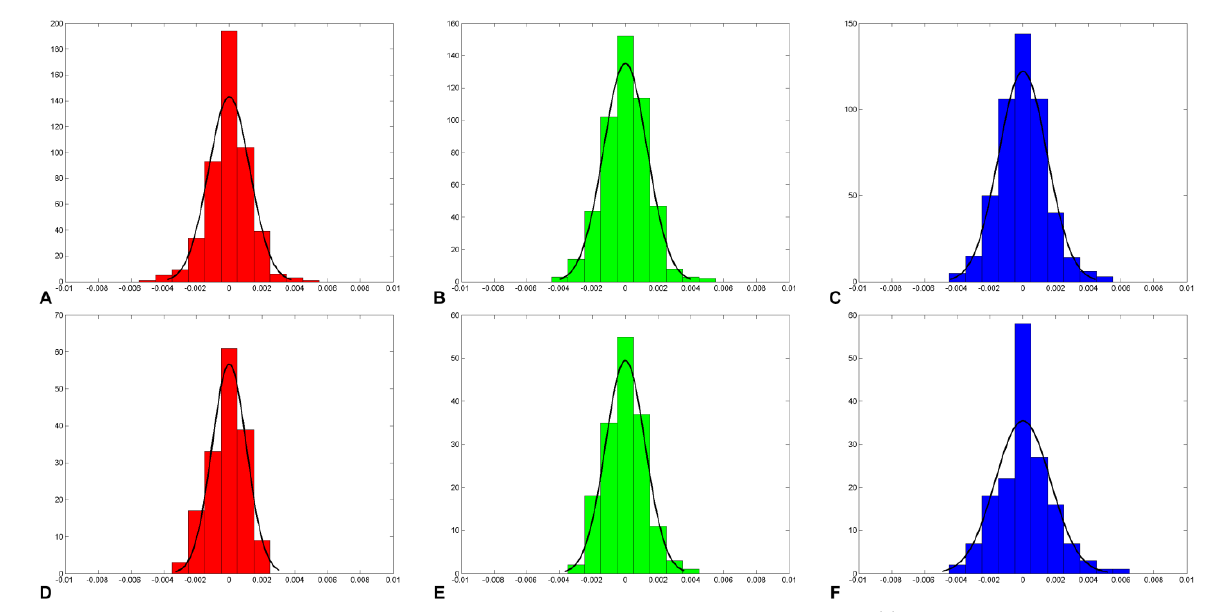
Figure 7: Histograms of the deviations of the control and check points for spherical images: (a) X direction in pixels - control; (b) Y direction in pixels - control; (c) Z direction in pixels - control; (d) X direction in pixels – check; (e) Y direction in pixels – check; (f) Z direction in pixels – check.